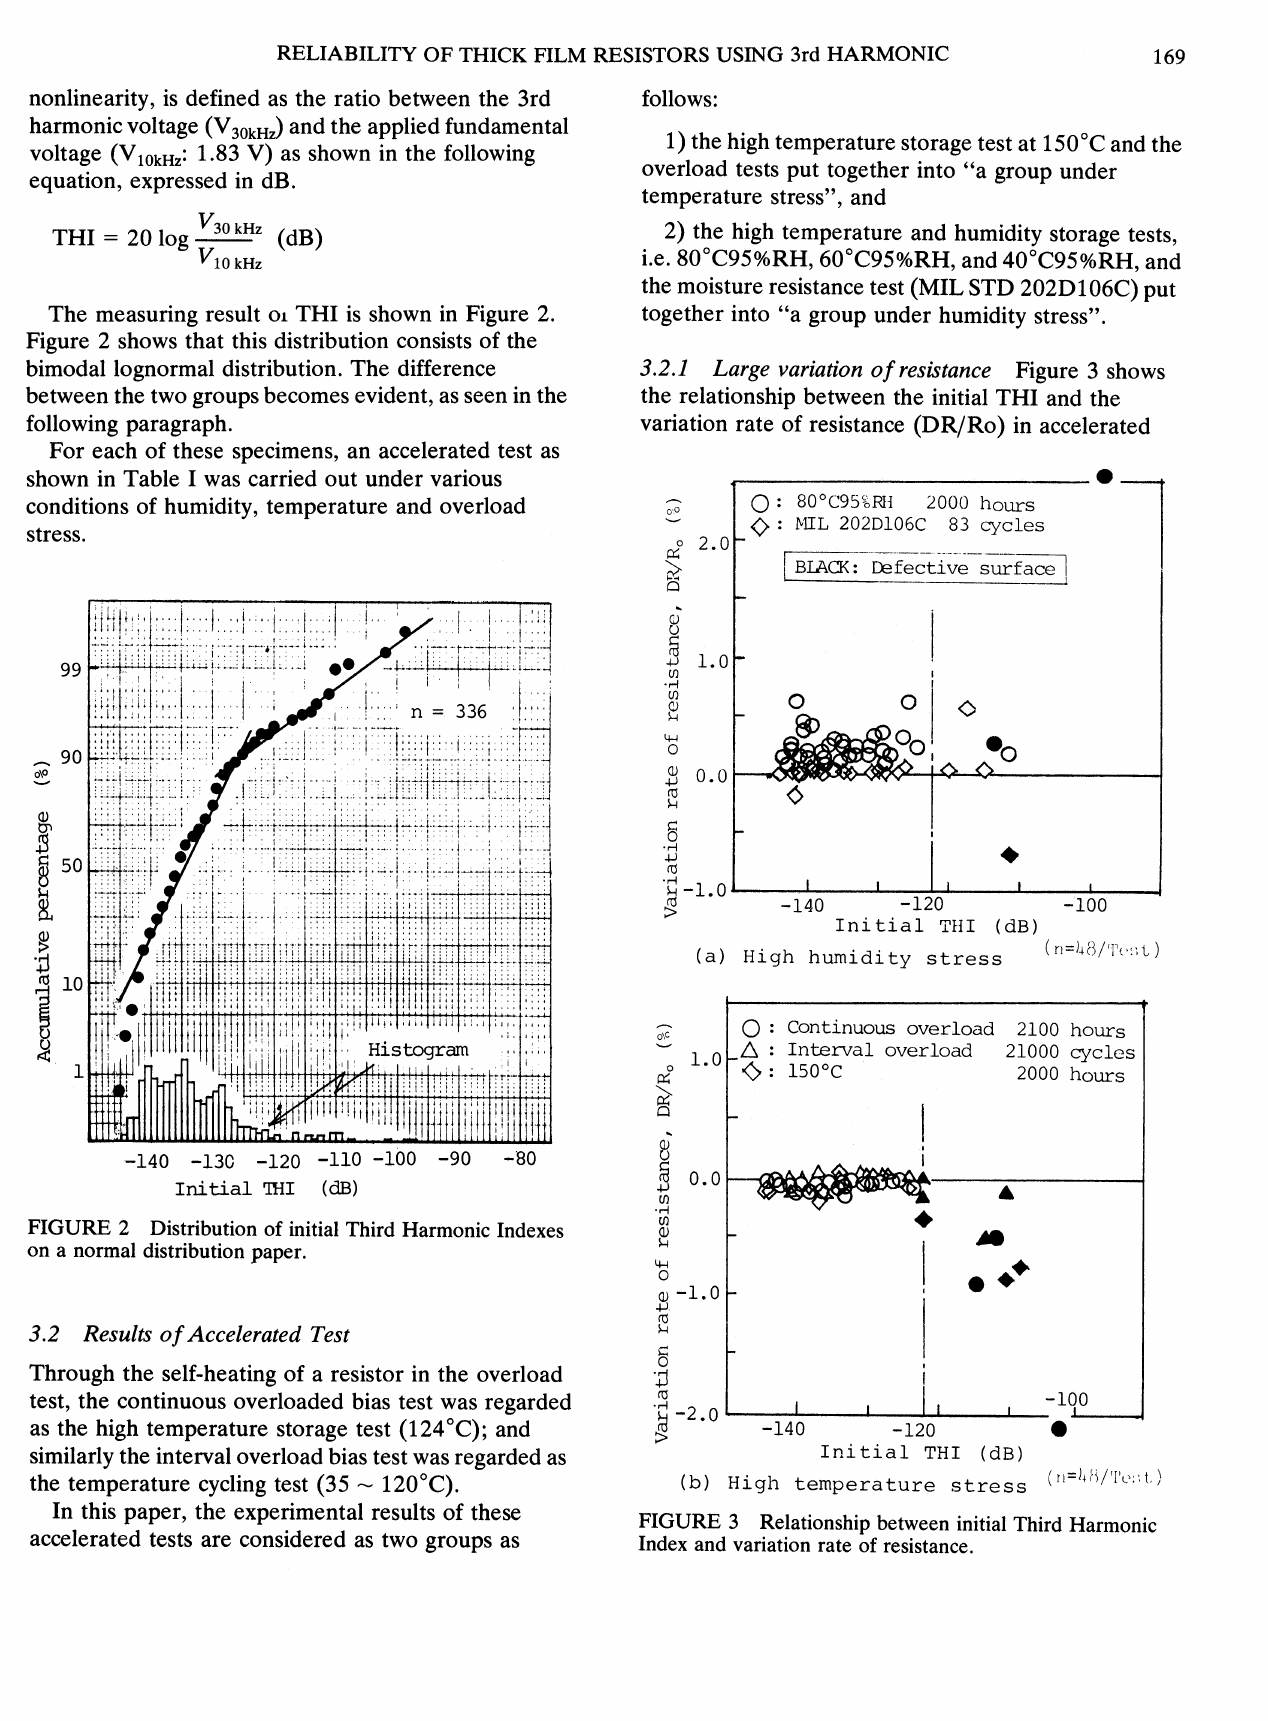
FIGURE 3 Relationship between initial Third Harmonic Index and variation rate of